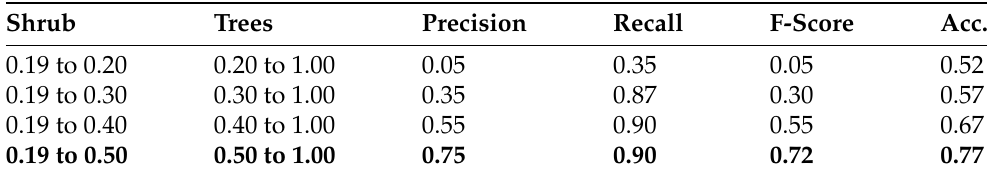
Table 8. Accuracy assessment using different threshold ranges at level-2 classification for shrub and trees regions. Note that each row represents the averaged metrics (Precision, Recall, F-score, and Accuracy) of four LGAs under Level-2 classification. The boldface represents the optimal threshold range and resulting best